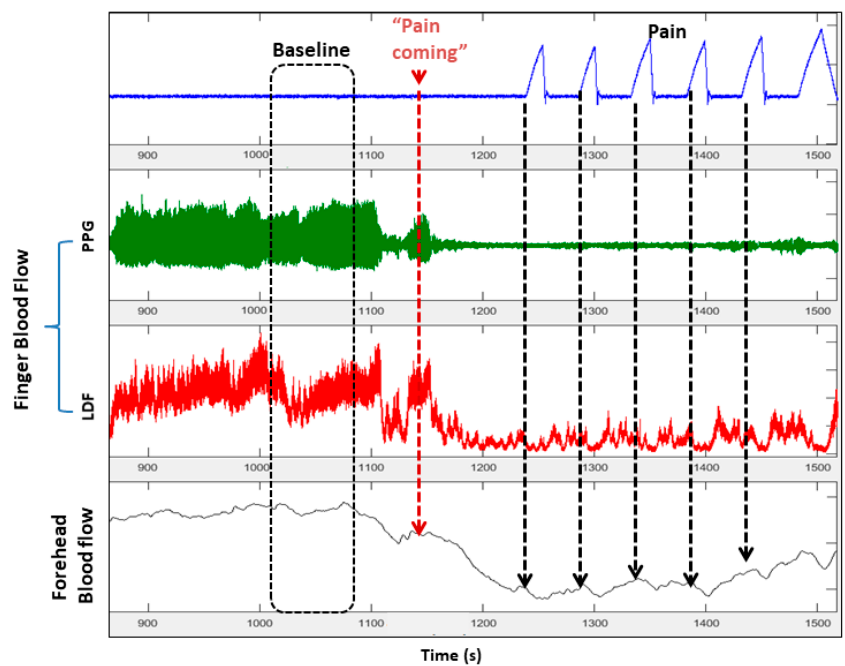
Figure 6. This zoomed section of data shows that significant global vasoconstriction starts when the subjects is informed that “the pain stimulation will start in about two minutes” with additional decreases corresponding to each of the heat pulses. Clearly, anticipation of pain, as well as pain itself, causes vasoconstriction.